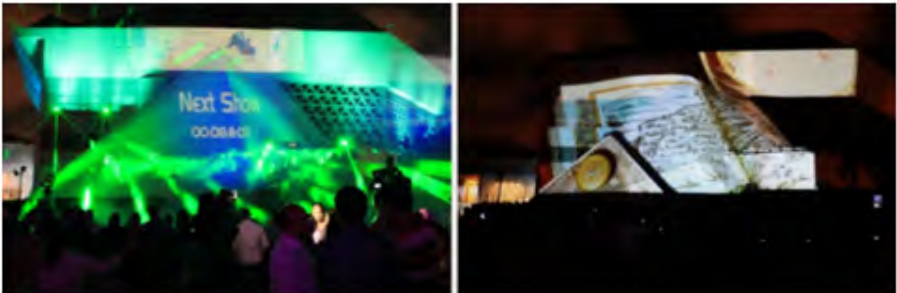
Figure 9. 3D Mapping on the Library of